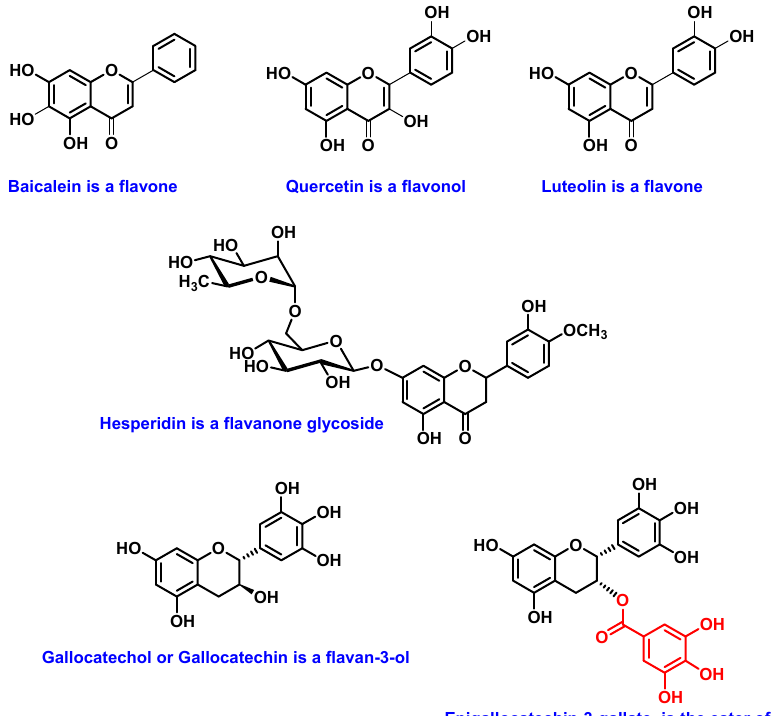
Figure 5. Examples of polyphenols. Polyphenols can be categorized as flavonoids (including anthocyanins, flavanes, flavonols, isoflavones, and flavan-3ols). Polyphenols tend to share a variety of unique chemical properties, including the presence of a phenolic ring with hydroxyl groups.